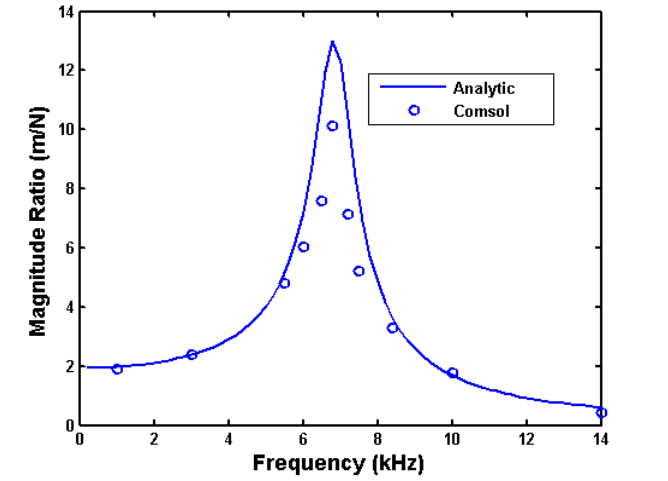
Figure 8. Comparison of analytical and numerical frequency responses for square plate with no hole, at ambient pressure of 300 Pa, with folded leg stiffness of 0.5165